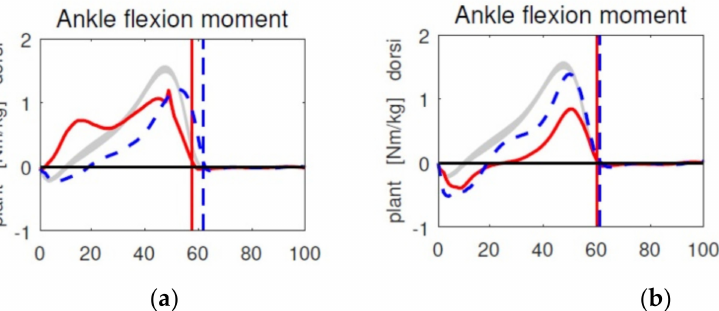
Figure 1. Demonstration of the steep increase of the plantar flexor moment during toe-walking gait ( a ) and the reduced moment when walking with an orthosis ( b ); affected side left (red), unaffected side dotted blue, normal range